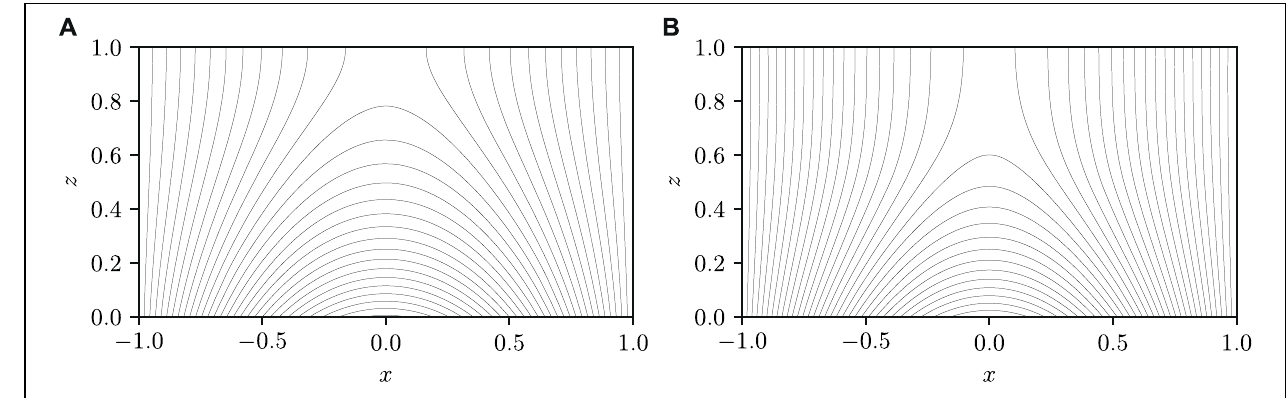
FIGURE 1 | Examples of initial conditions for the 2.5D magneto-frictional code in a cartesian domain. Here (A) is a potential field and (B) is an equivalent outflow field, with the same lower boundary condition. The black lines represent magnetic field